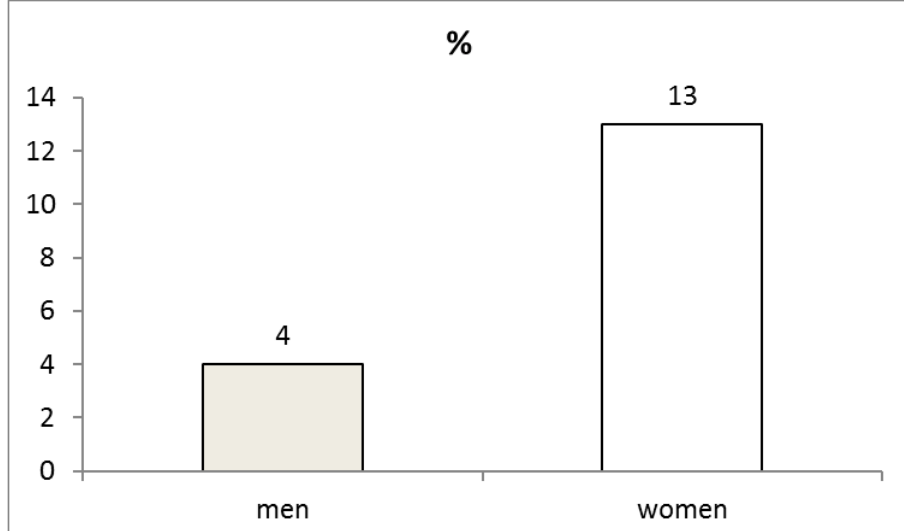
Figure 1. The comparison of injury rate by